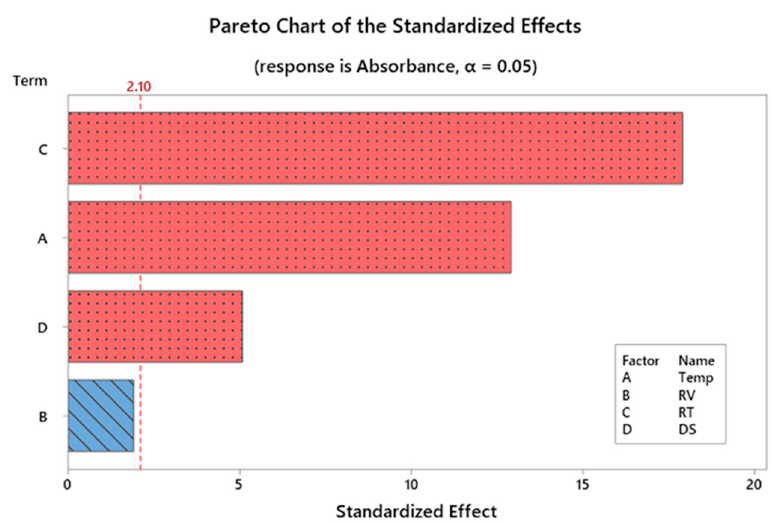
Figure 2. Pareto chart of the studied variables showing the statistical significance of each variable on the absorbance of the colored CTC following response transformation. Table 3. Analysis of variance (ANOVA)